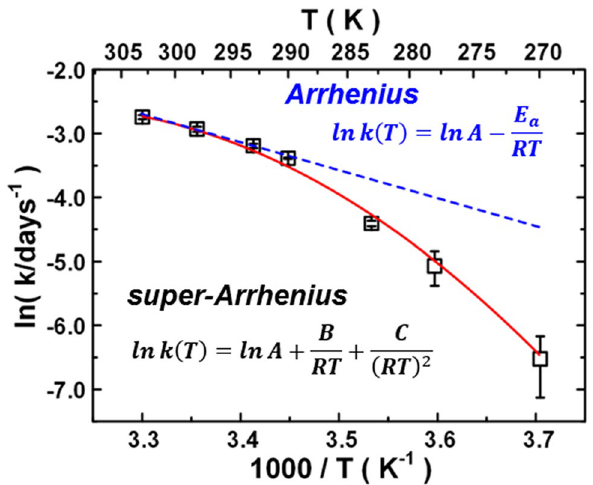
Figure 1. Arrhenius plot of logarithm of reaction rate constants as a function of inverse absolute temperature K. The dashed line in blue indicates the linear Arrhenius plot as a reference. The convex line in red indicates the super-Arrhenius plot as a reference 9